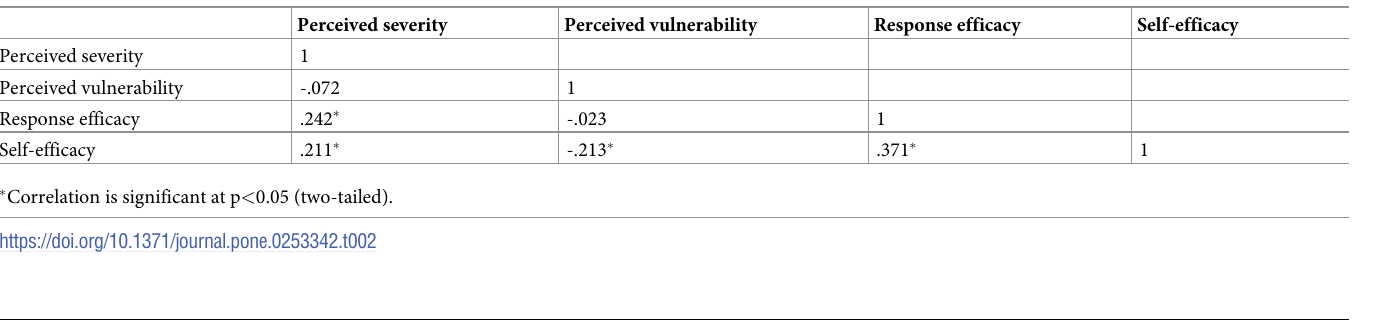
Table 2. Spearman correlations (R s ) between fear, concern, perceived severity, vulnerability, response efficacy and